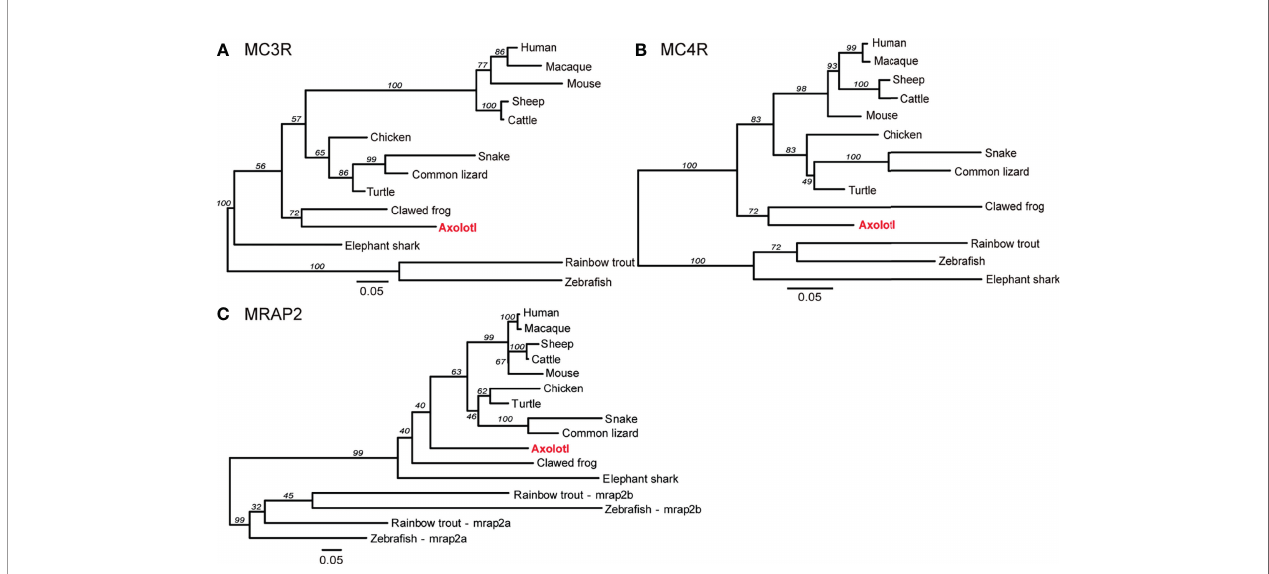
FIGURE 2 | Phylogenetic analysis of MC3R, MC4R, and MRAP2. Phylogenetic trees of (A) MC3R, (B) MC4R, and (C) MRAP2. The ML phylogenetic tree was inferred based on multiple alignments of protein sequences using RAxML v8.2 with the PROTGAMMAJTT protein model and 1,000 rapid bootstrap